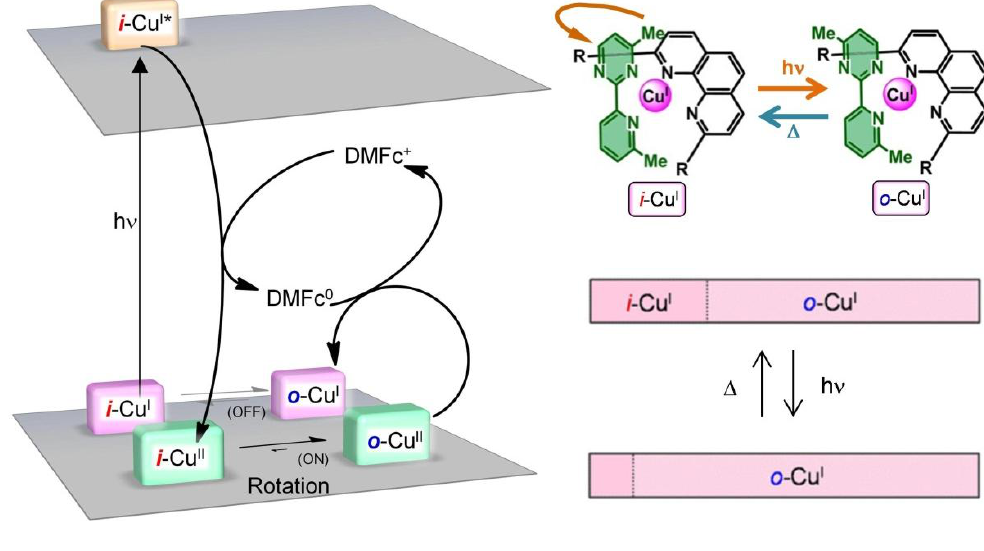
Figure 10. Schematic representation of the PET-driven i -Cu I -to- o -Cu I ligand geometry isomerization of 1  BF in the presence of DMFc + . The reversible changes in the molar 4 ratios of the isomers upon light irradiation and heating are illustrated in the bottom panels. Adapted with permission from [42]. Copyright (2012) American Chemical